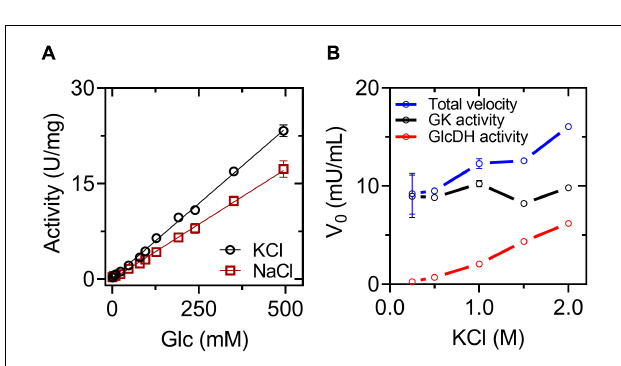
FIGURE 3 | Glucose dehydrogenase (GlcDH) activity and coupled assay for GK activity. (A) Saturation curves for glucose at 2 M salt. The reactions were assayed at 25 ◦ C in the presence of 3 mM NAD + . (B) Coupled assay for GK form Thermococcus litoralis ( Tl GK), employing 2 U/ml of Hv G6PDH as an auxiliary enzyme at 25 ◦ C in the presence of 3 mM NAD + , 5 mM glucose, 1 mM ADP, and 6 mM MgCl 2 . The means and standard deviations are shown. For (A) , n = 3, and for (B) , n =